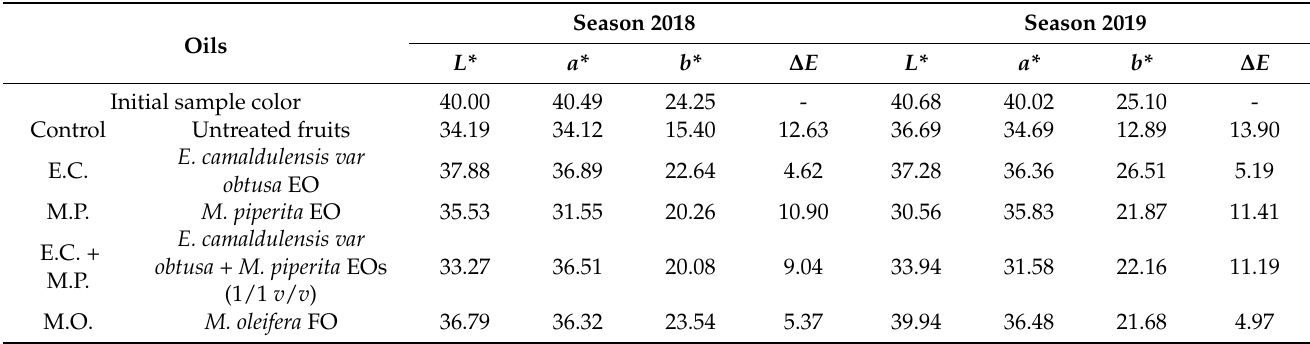
Table 3. Chromatic parameters measured in the L*, a* and b* color system of strawberry fruits as affected by the application of natural oils after 18 days of the storage at 5 ◦